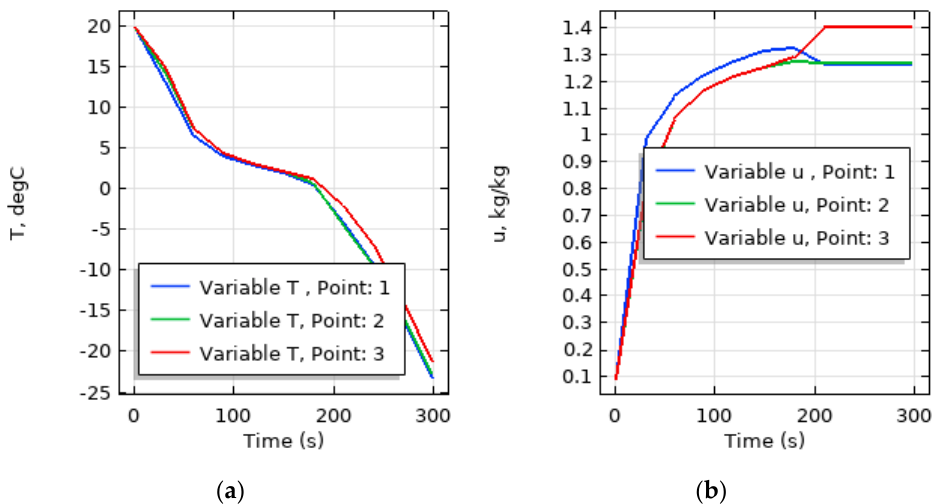
Figure 3. Distribution of moisture content (kg kg − 1 ) in the seed when the seed capsule is frozen at times 30 s ( a ), 120 s ( b ), 240 s, 300 s ( c ) for a seed with length of 4 mm, and thickness of 1.5 mm.